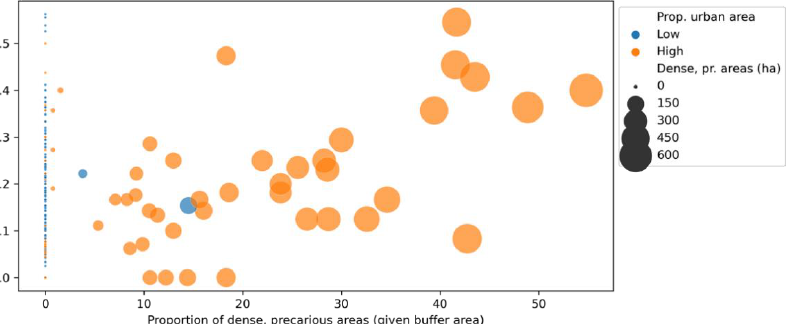
Figure 5. Relation between dense, precarious urban areas ( x -axis) and the prevalence of diarrhoea ( y -axis), by level of urbanisation (urban subset shown in orange). Elaborated by the authors.